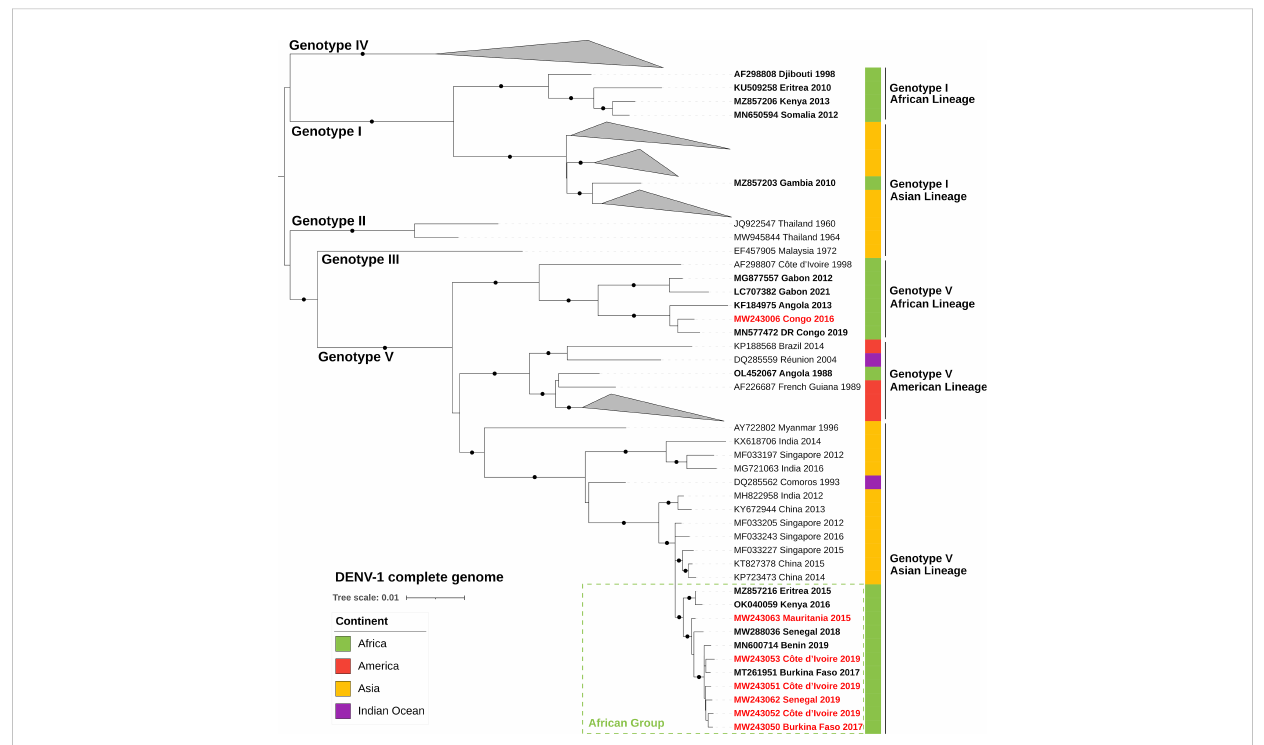
FIGURE 1 ML phylogenetic tree based on 117 complete CDSs of DENV-1 strains (10,102-nucleotide-long sequences after trimming). DENV-1 strains from African countries are indicated in bold and strains from our dataset are in red text. Each strain is identi fi ed by its GenBank accession number, country of origin, and year of sample collection. The tree was rooted at the mid-point and bootstrap values equal to 100% are indicated by a black circle on the branch. The scale bar indicates genetic distance (nucleotide substitutions per site). The color strip indicates location of infection. DENV, dengue virus; DR Congo, Democratic Republic of the